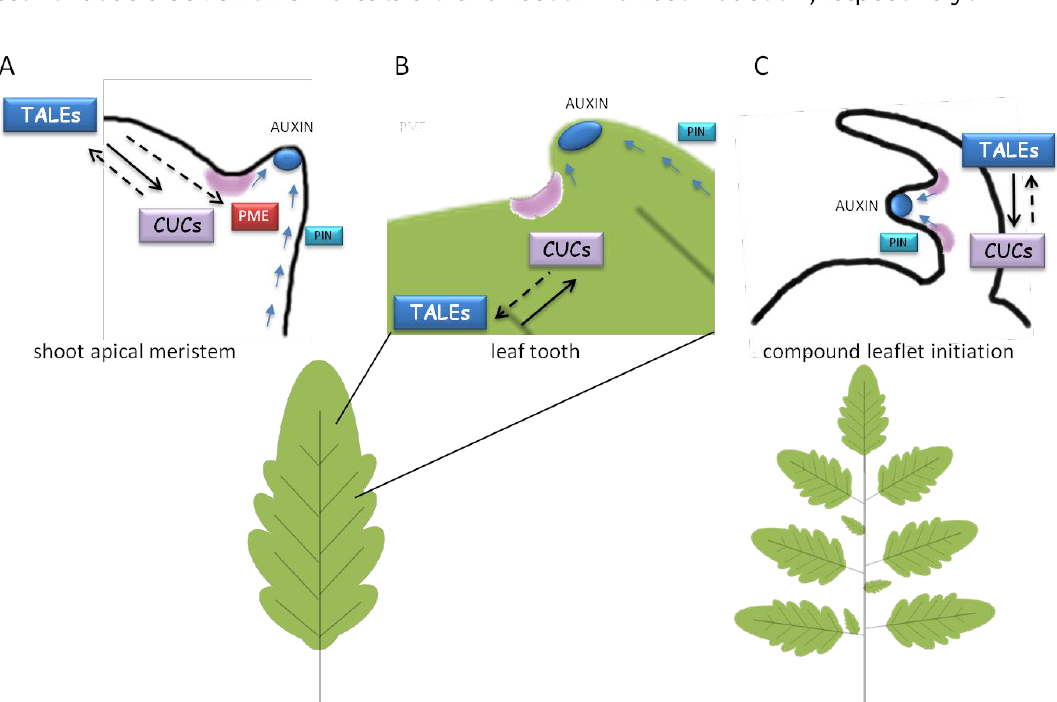
Figure 5. Common genetic pathways involved in lateral organ formation at the SAM ( A ), formation of leaf serrations ( B ) or leaflets in compound leaf development ( C ). PIN1-dependent auxin transport (blue arrows) leads to formation of auxin maxima (blue smarties) for organ/tissue outgrowth. Localized CUC s expression (in purple) and a positive feedback loop between CUCs and TALEs are required for setting boundaries and proper organ separation. TALE would maintain the indeterminate environment for morphogenesis whereas auxin and CUCs would ensure organ/tissue patterning and separation. In the SAM, TALEs would repress PME expression to prevent cell expansion. Continuous or discontinuous black arrows indicate either direct or indirect induction,